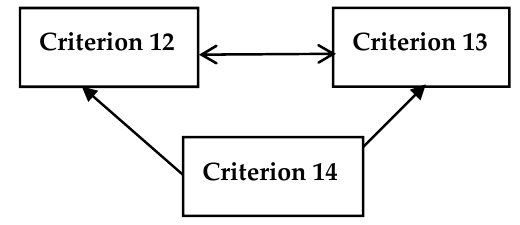
Figure 7. Impact-relation map for the criteria of sustainable economic growth.